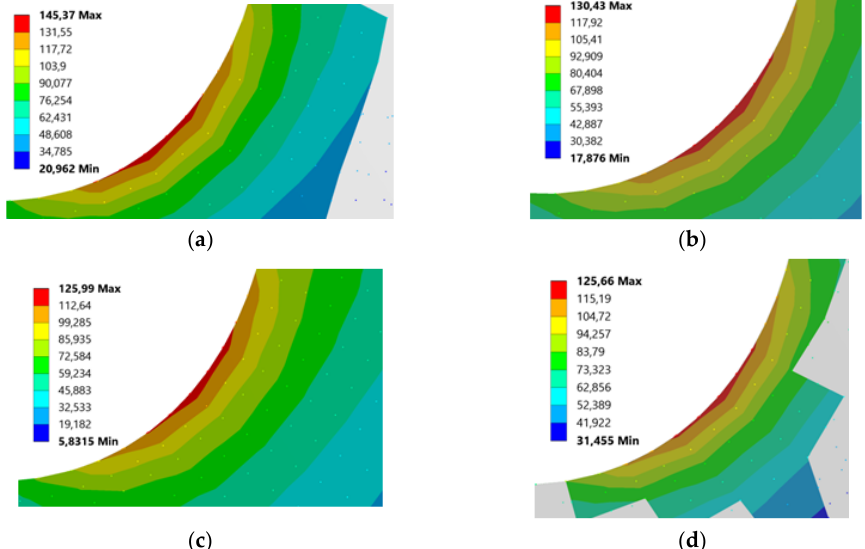
Figure 18. Root stress results for hybrid gears with α d = 30° for different RTs; ( a ) 0.5 xm, ( b ) 1 xm, ( c ) 1.5 xm, ( d ) 2 xm.